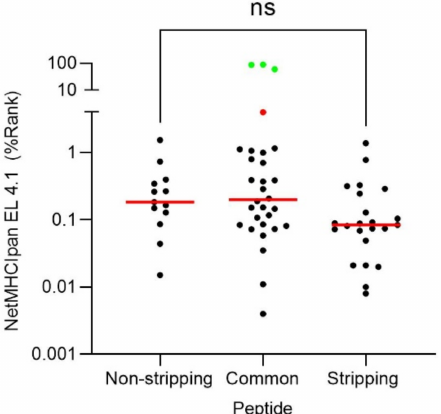
Figure 2. Theoretical binding affinity of the VACV HLA-B*27:05 ligands identified by mass spec- trometry. The theoretical binding affinity to the HLA-B*27:05 class I molecule of the different VACV ligands (classified by exclusives for untreated or acid stripping conditions, as well as peptides iden- tified in these two conditions or common peptides) was calculated with the NetMHCIpan EL 4.1 server. The threshold for strong binding peptides (marked as black dots) was 2 of the percentile rank. One peptide (marked as red dot) ranked as weak binding. In addition, another 3 peptides (marked as green dots) showed no theoretical affinity for